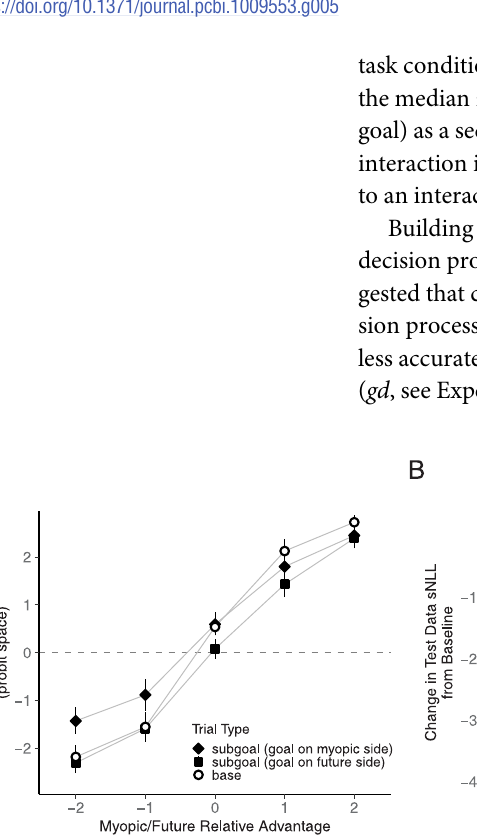
Fig 6. Weighted consideration of subgoal-relevant and -irrelevant constraints approximated optimal choice behavior when the base task was embedded as an initial subgoal task. A. Path choices in the IA trials. As in Figs 3B and 5B, the proportion of optimal trials for each individual was converted into a probit score, with individual probit scores larger than 3 or smaller than -3 capped at 3 or -3 before averaging. B. Test data objective (summed negative log-likelihood) of the candidate drift-diffusion models compared to the baseline model. Asterisk marks the winning model. For empirical and predicted response time distributions, see S4 Fig. C. Parameter estimates from the winning model. t 0 , non-decision time. a , decision bound. md and fd , myopic and future advantage weights. gd , goal weight. sz , inter-trial variability of the starting point. sd , inter-trial variability of the drift rate. p , proportional change to md and fd in the subgoal trials.